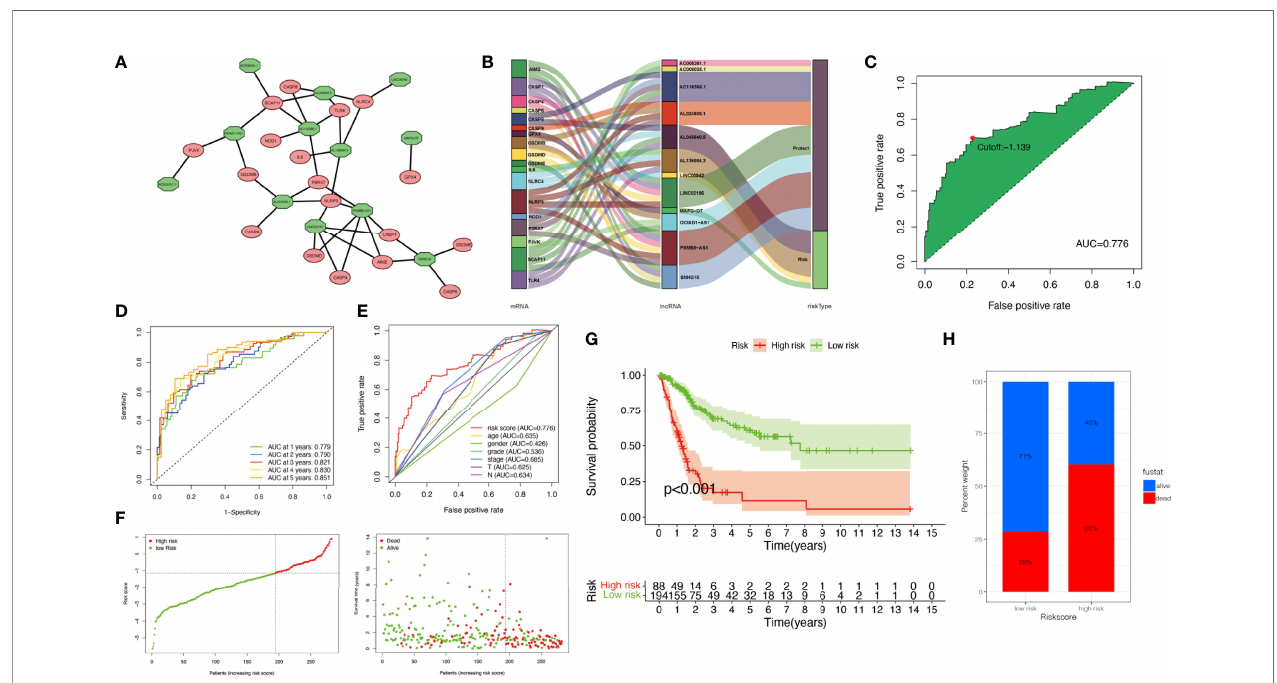
FIGURE 3 | Construction of risk signature in the meta-data cohort. (A) The relationship between pyroptosis-related genes (red circle) and lncRNAs (green circle). (B) The alluvial diagram was used to visualize the attribute changes of pyroptosis-related mRNAs. (C) Receiver operating characteristic (ROC) curves were plotted for examining the most predictive ef fi cacy of the signature. (D) Area under the curve (AUC) of time-dependent ROC curves veri fi ed the prognostic performance of the risk score. (E) A comparison of 5-year ROC curves with other common clinical characteristics showed the superiority of the riskScore. (F) Distribution of patients in The Cancer Genome Atlas (TCGA) cohort based on the median risk score and survival status for each case. (G) Kaplan – Meier curves of the overall survival (OS) between low- and high-risk groups. (H) Rate of clinical outcome in the low- and high-risk